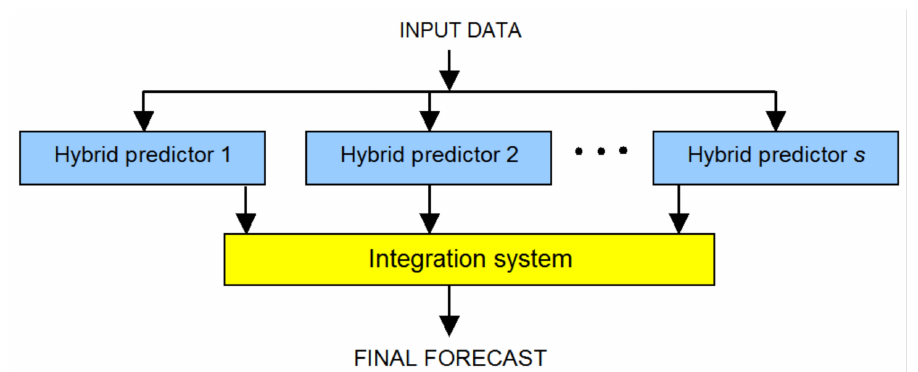
Figure 10. The general scheme of ensemble of predictors based on hybrid